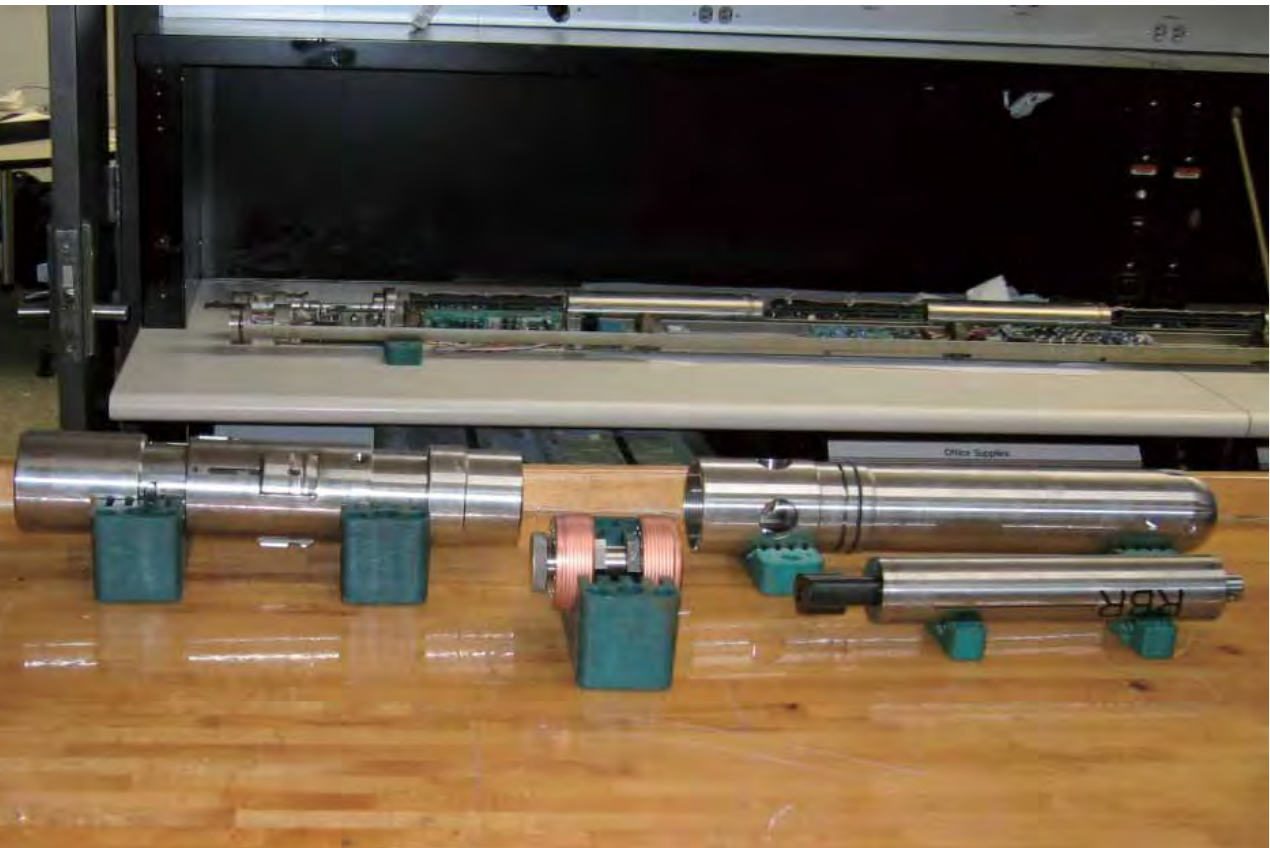
Figure 3. Assembling the data logger and thermistor string in the JOIDES Resolution Downhole Laboratory. The fi gure shows upper components of instru- mentation. In the background (left) is the XN lock mandrel for latching the system into the CORK assembly. Foreground middle shows slip joint connecting the mandrel to battery pack housing. Foreground (right) shows pressure casing for bottom water temperature thermistor and back-up battery pack. Below this assembly is another housing containing batteries, data logger, and thermistor